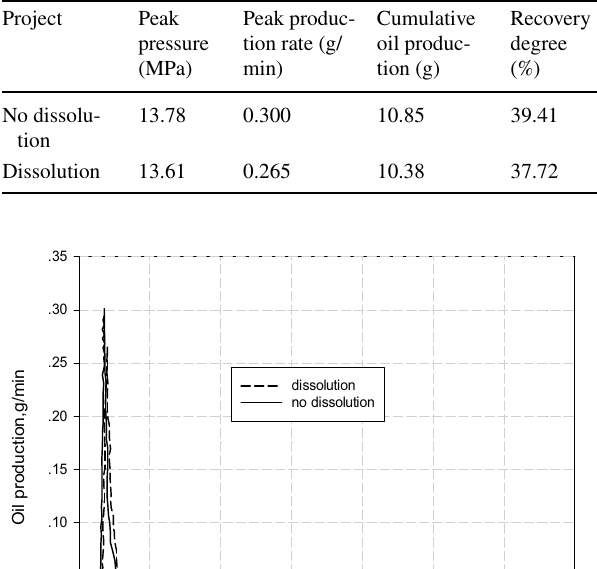
Table 5 Dissolution function parameters in the CO